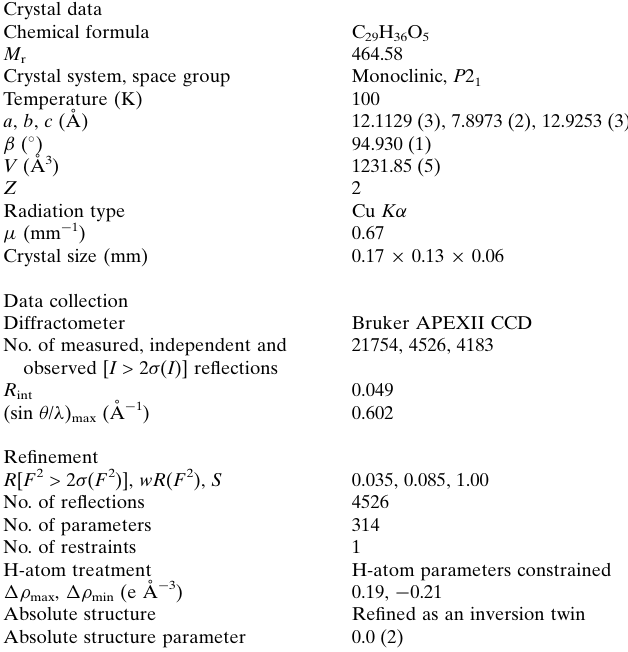
Crystal data Chemical